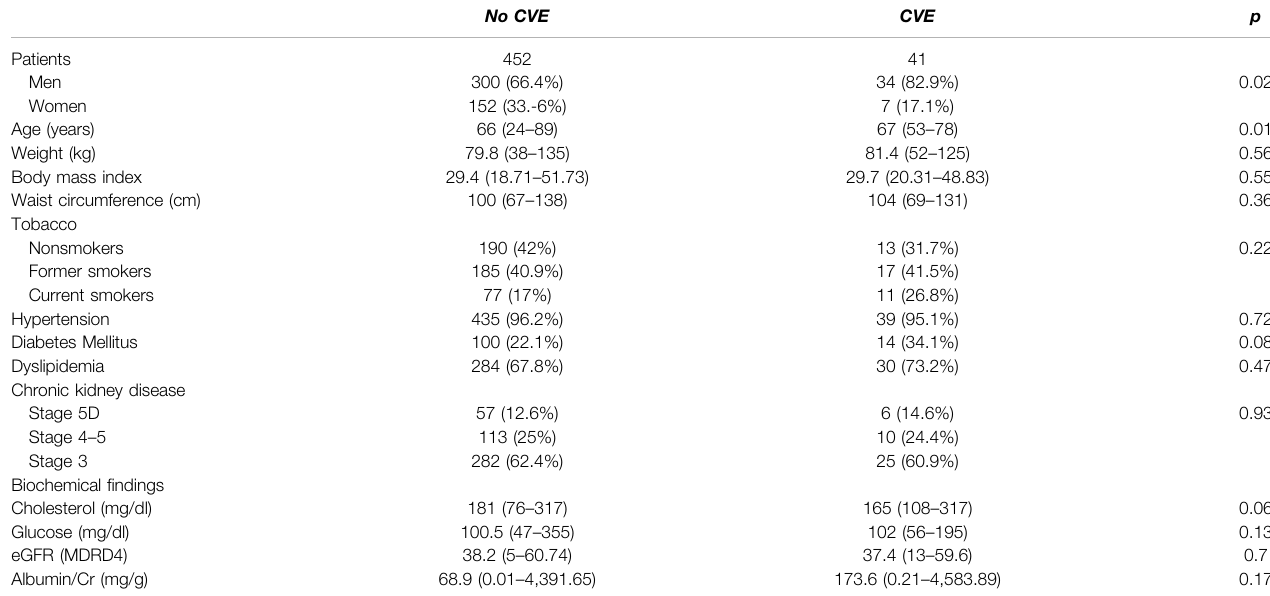
TABLE 4 | Demographic, biochemical and clinical characteristics of nephrosclerosis patients with or without cardiovascular events (CVE) recorded during the four-year